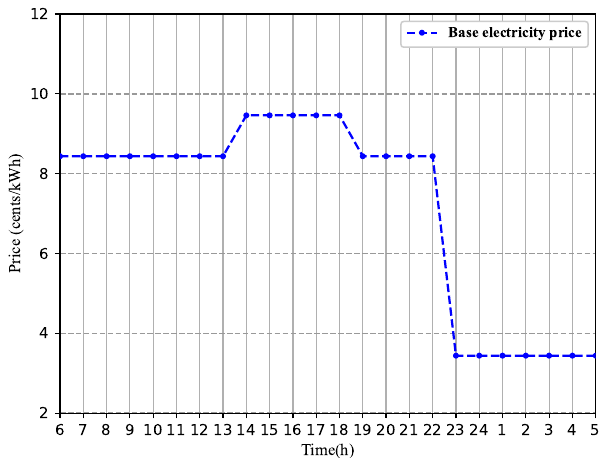
Figure 4. Price signal for